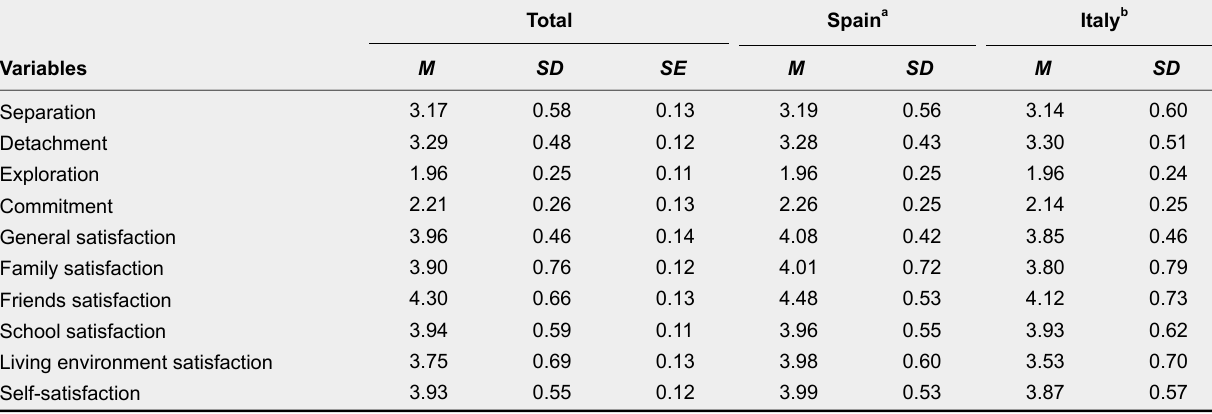
Descriptive Statistics for the Total Sample, for Spain and